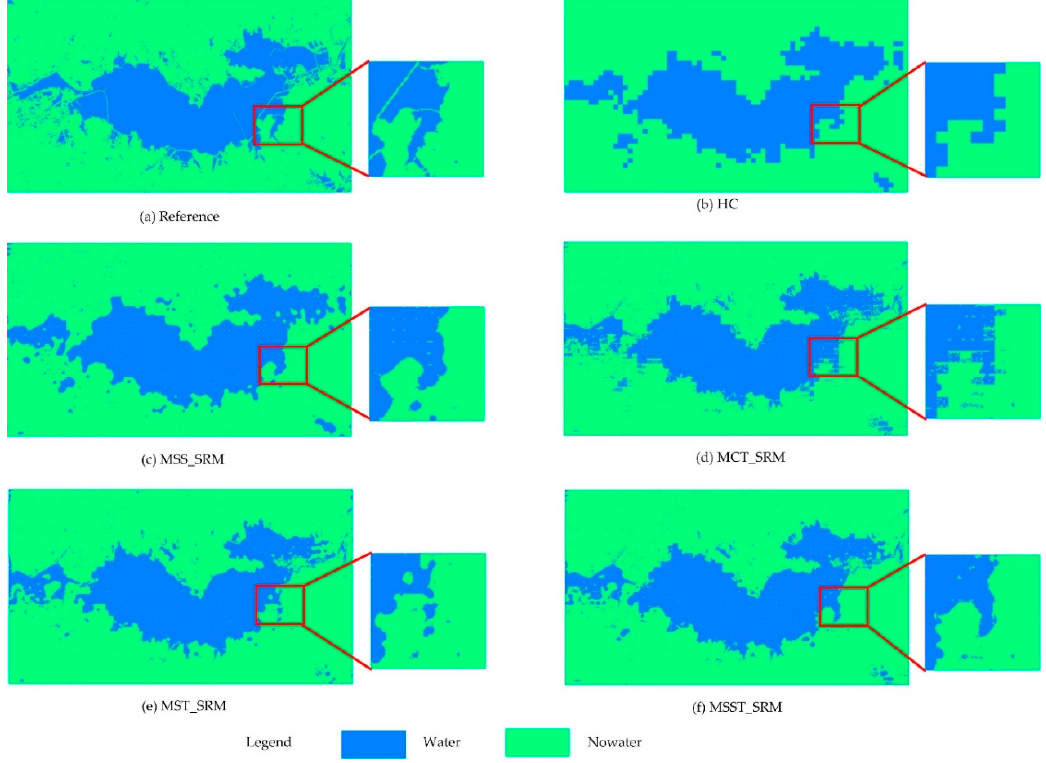
Figure 8. Resultant water body maps of the different methods for Daye Lake ( a ) reference; ( b ) HC; ( c ) MSS_SRM; ( d ) MCT_SRM; ( e ) MST_SRM; ( f ) MSST_SRM.